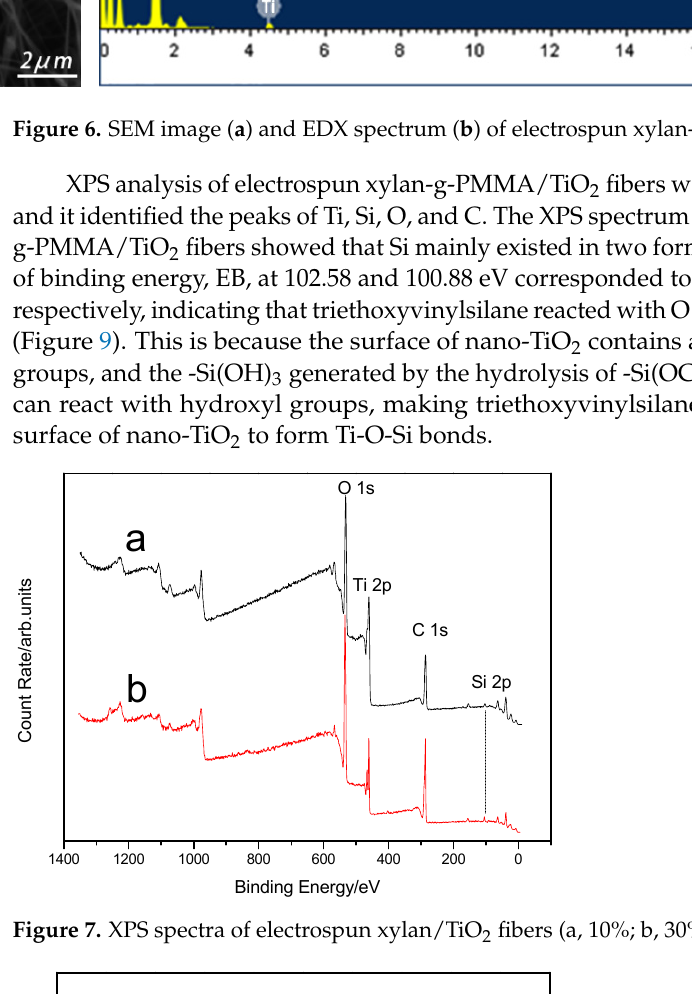
Figure 7. XPS spectra of electrospun xylan/TiO 2 fibers (a, 10%; b, 30%).